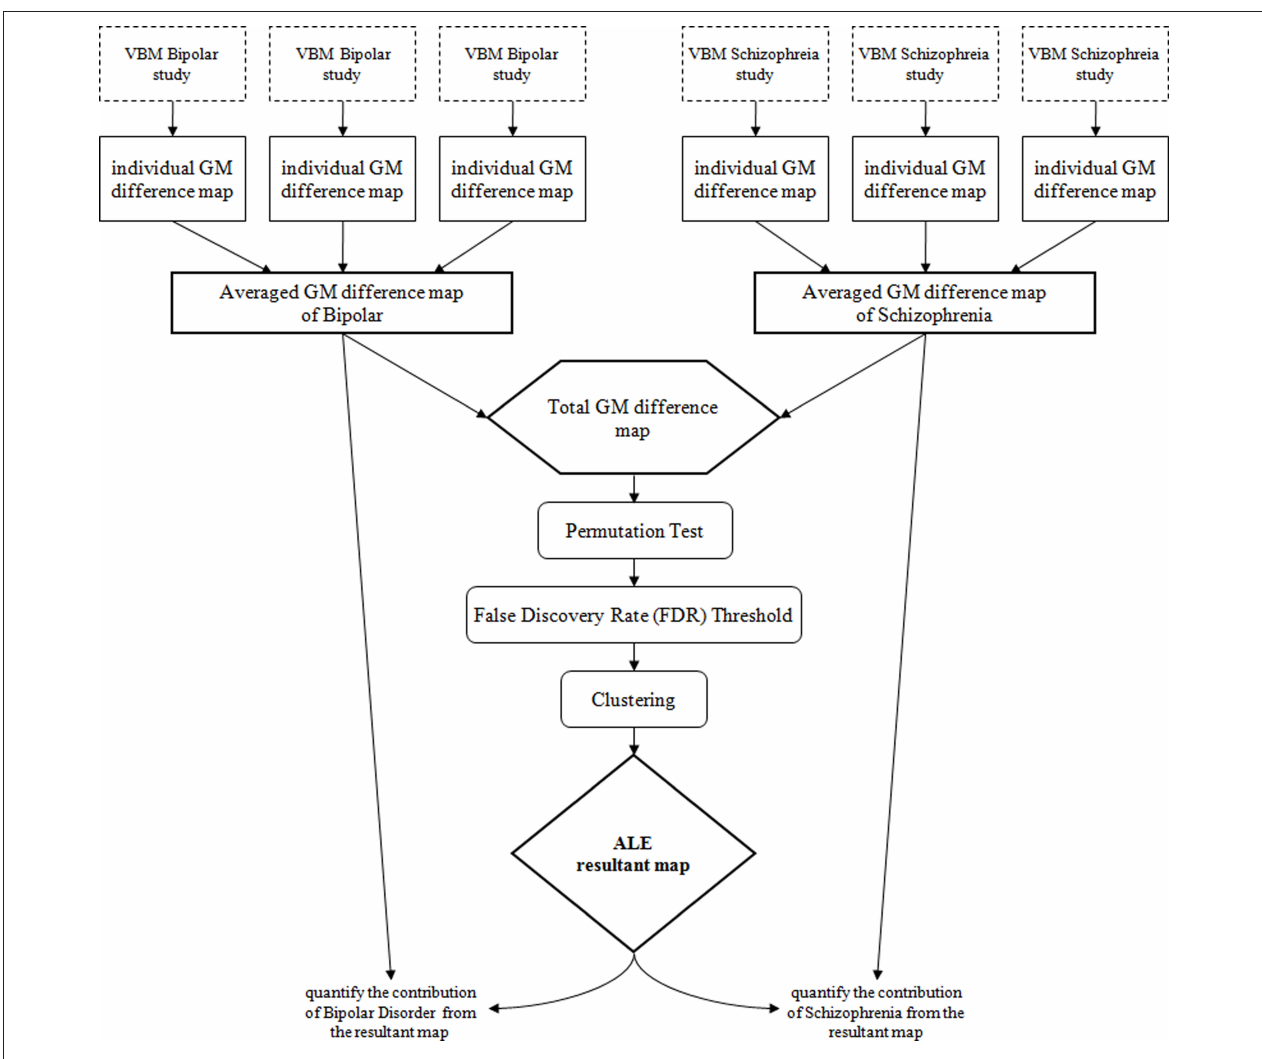
FiguRe 1 | Flow chart of dual disorder ALe